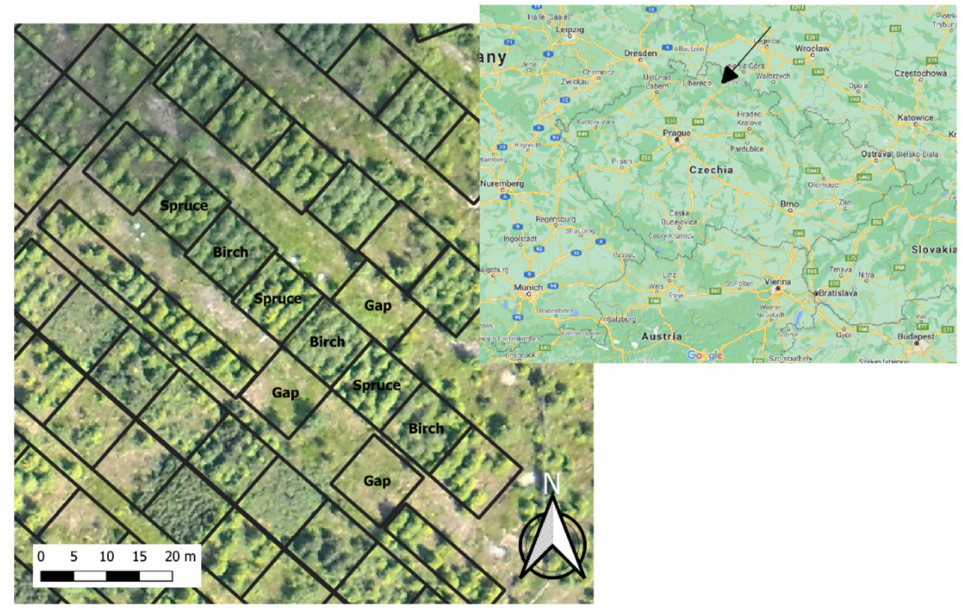
Figure 1. Aerial photograph of the research area (J. Vondra on the 6 July 2011). Treatment names show plots 10 × 10 m analyzed within the